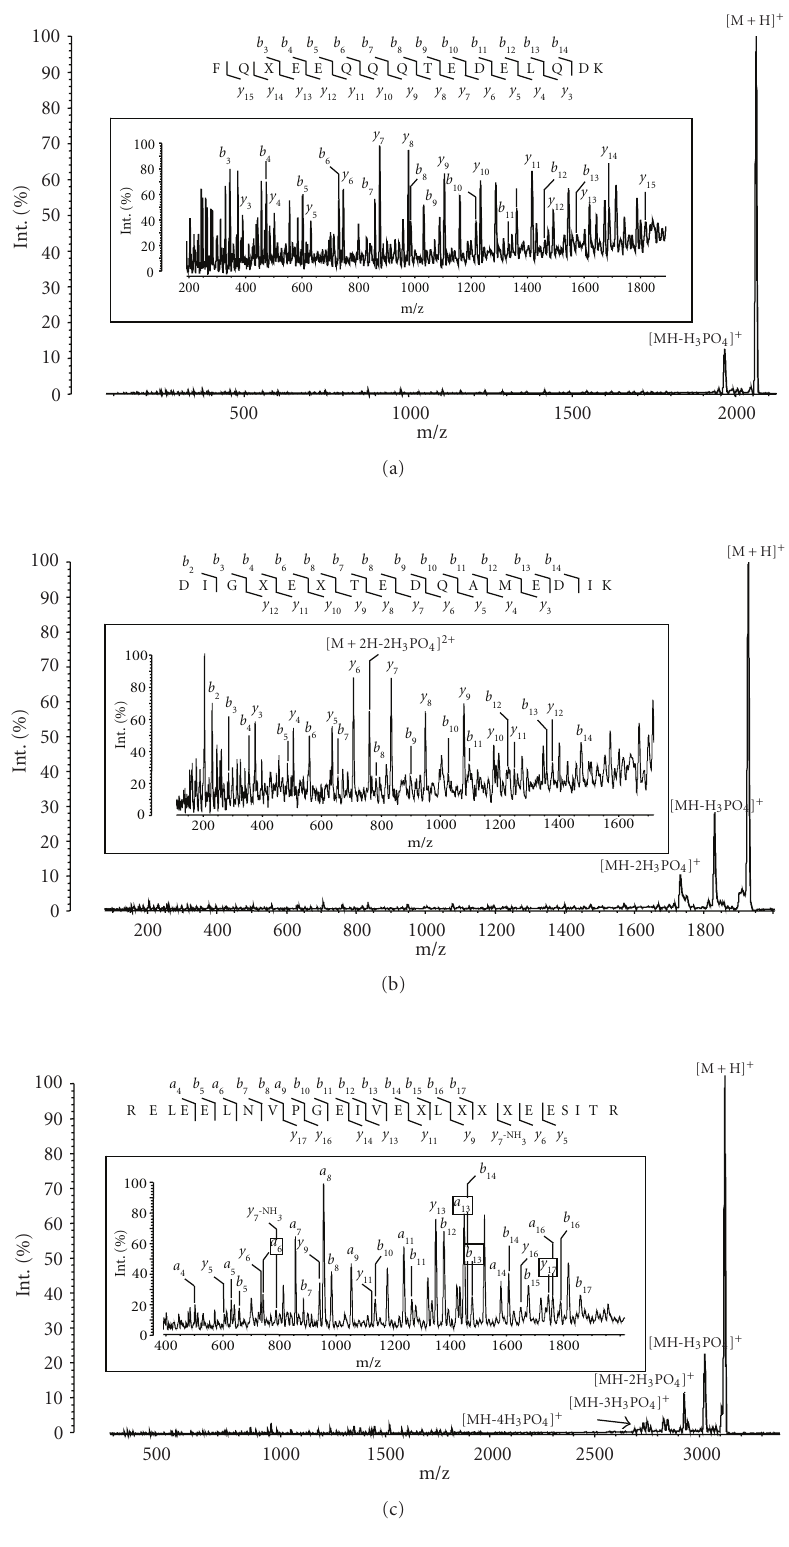
Figure 6: The MALDI MS/MS spectra of phosphopeptides (a) T β 1, (b) T α 3, and (c) T β 2 (250fmol for each on target) from α -casein and β -casein were obtained by MALDI-TOF/TOF MS. The sequential losses of H 3 PO 4 from the parent ions are noted. The fragment patterns of the peptides are indicated in the magnified MS/MS spectra. “ X ” in the amino sequence shows a dehydroalanine residue converted from a phosphoserine residue by beta-elimination of H 3 PO 4